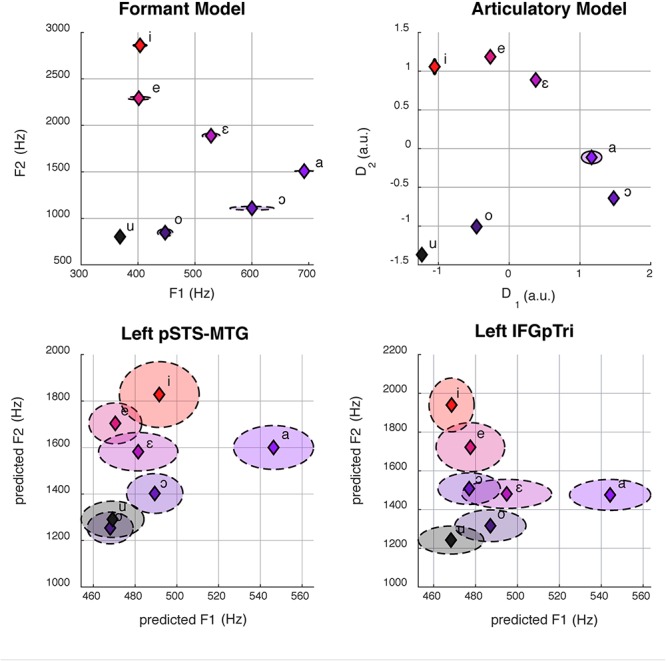
Here we show formant space (top left) and articulatory space (top right). The bottom panel shows the reconstruction of formant space (bottom left and right) from group-level brain activity in the left pSTS-MTG (center, R2 = 0.40) and IFGpTri (right, R2 = 0.39) through CCA. Dashed ellipses represent standard errors. Articulatory space reconstruction is not reported for lack of statistical significance.